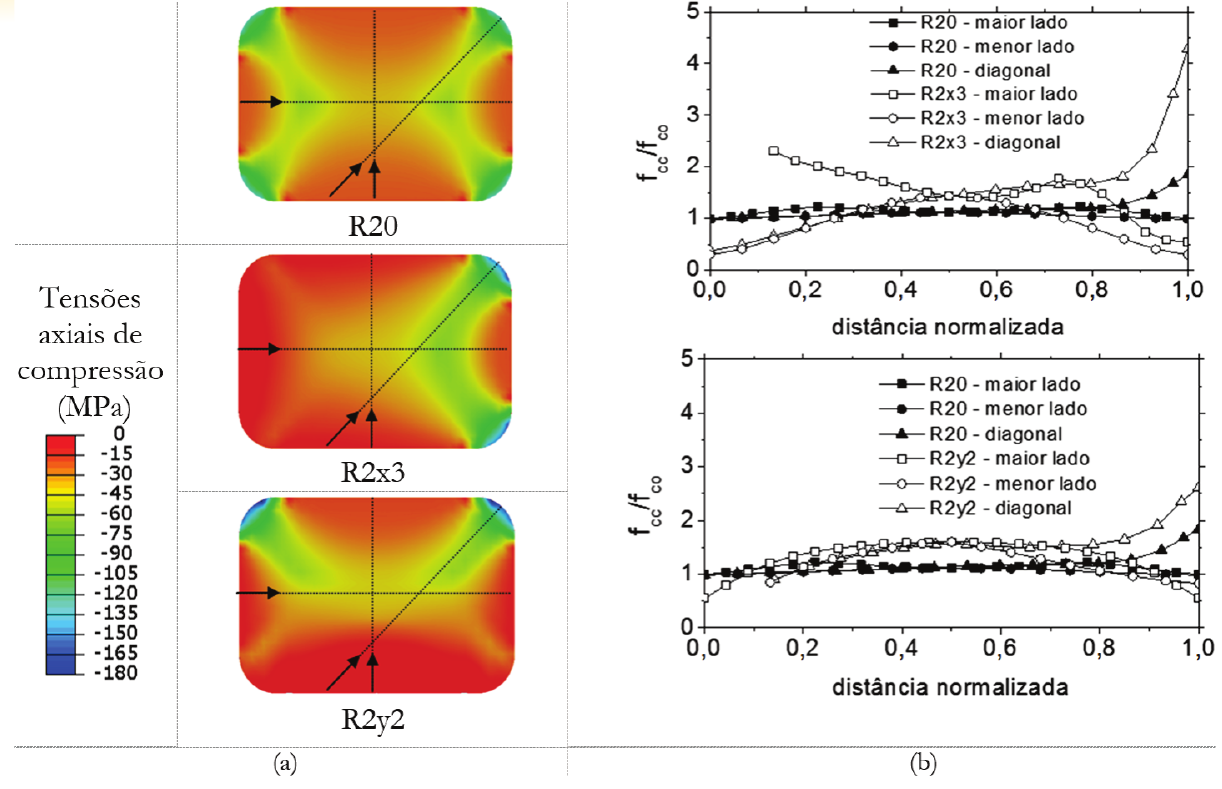
Figura 14 Tensões de compressão em pilares retangulares R2x3 e R2y2 (valores em MPa):